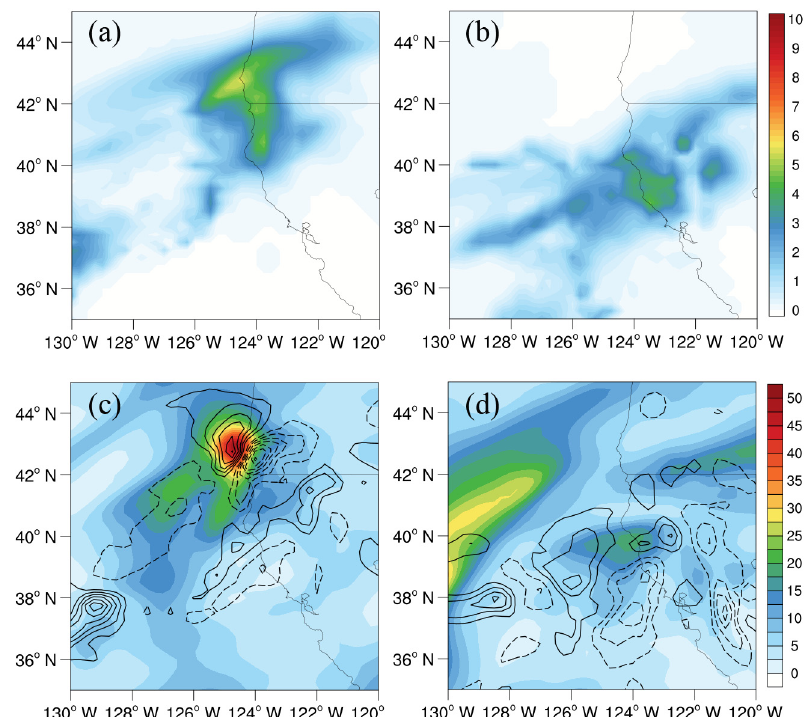
Figure 6. Spatial distributions of the hourly rainfall (in mm): ( a ) 25 February 09:00–10:00 UTC and ( b ) 26 February 17:00–18:00 UTC. Horizontal maps of the mesoscale KE ( K 2 ; shadings; in m 2 s − 2 ) and vertical velocity ( − ω ∼ 2 ; contours; in Pa/s) averaged vertically from 900 to 300 hPa: ( c ) 25 February 10:00 UTC and ( d ) 26 February 18:00 UTC. Solid contours represent the ascending motion with an interval of 0.2 (the contour with zero value is not drawn).